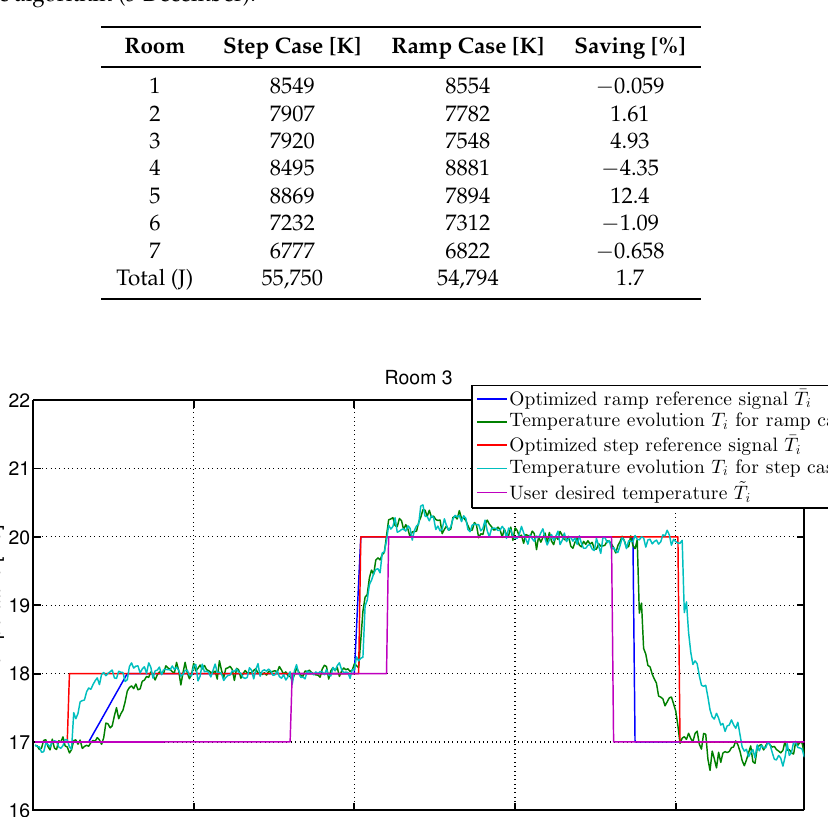
Table 5. Fan-coil performance index value (4) for both step and ramp set-point signals determined by the genetic algorithm (5 December).